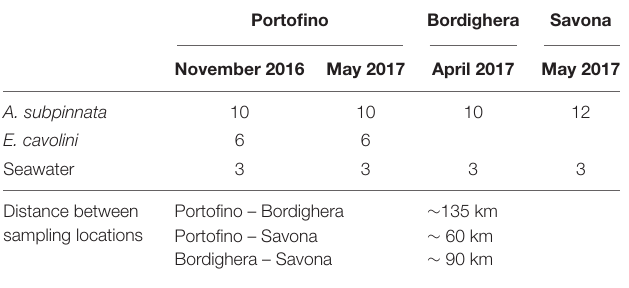
TABLE 1 | Overview of sample collection and distances between sampling